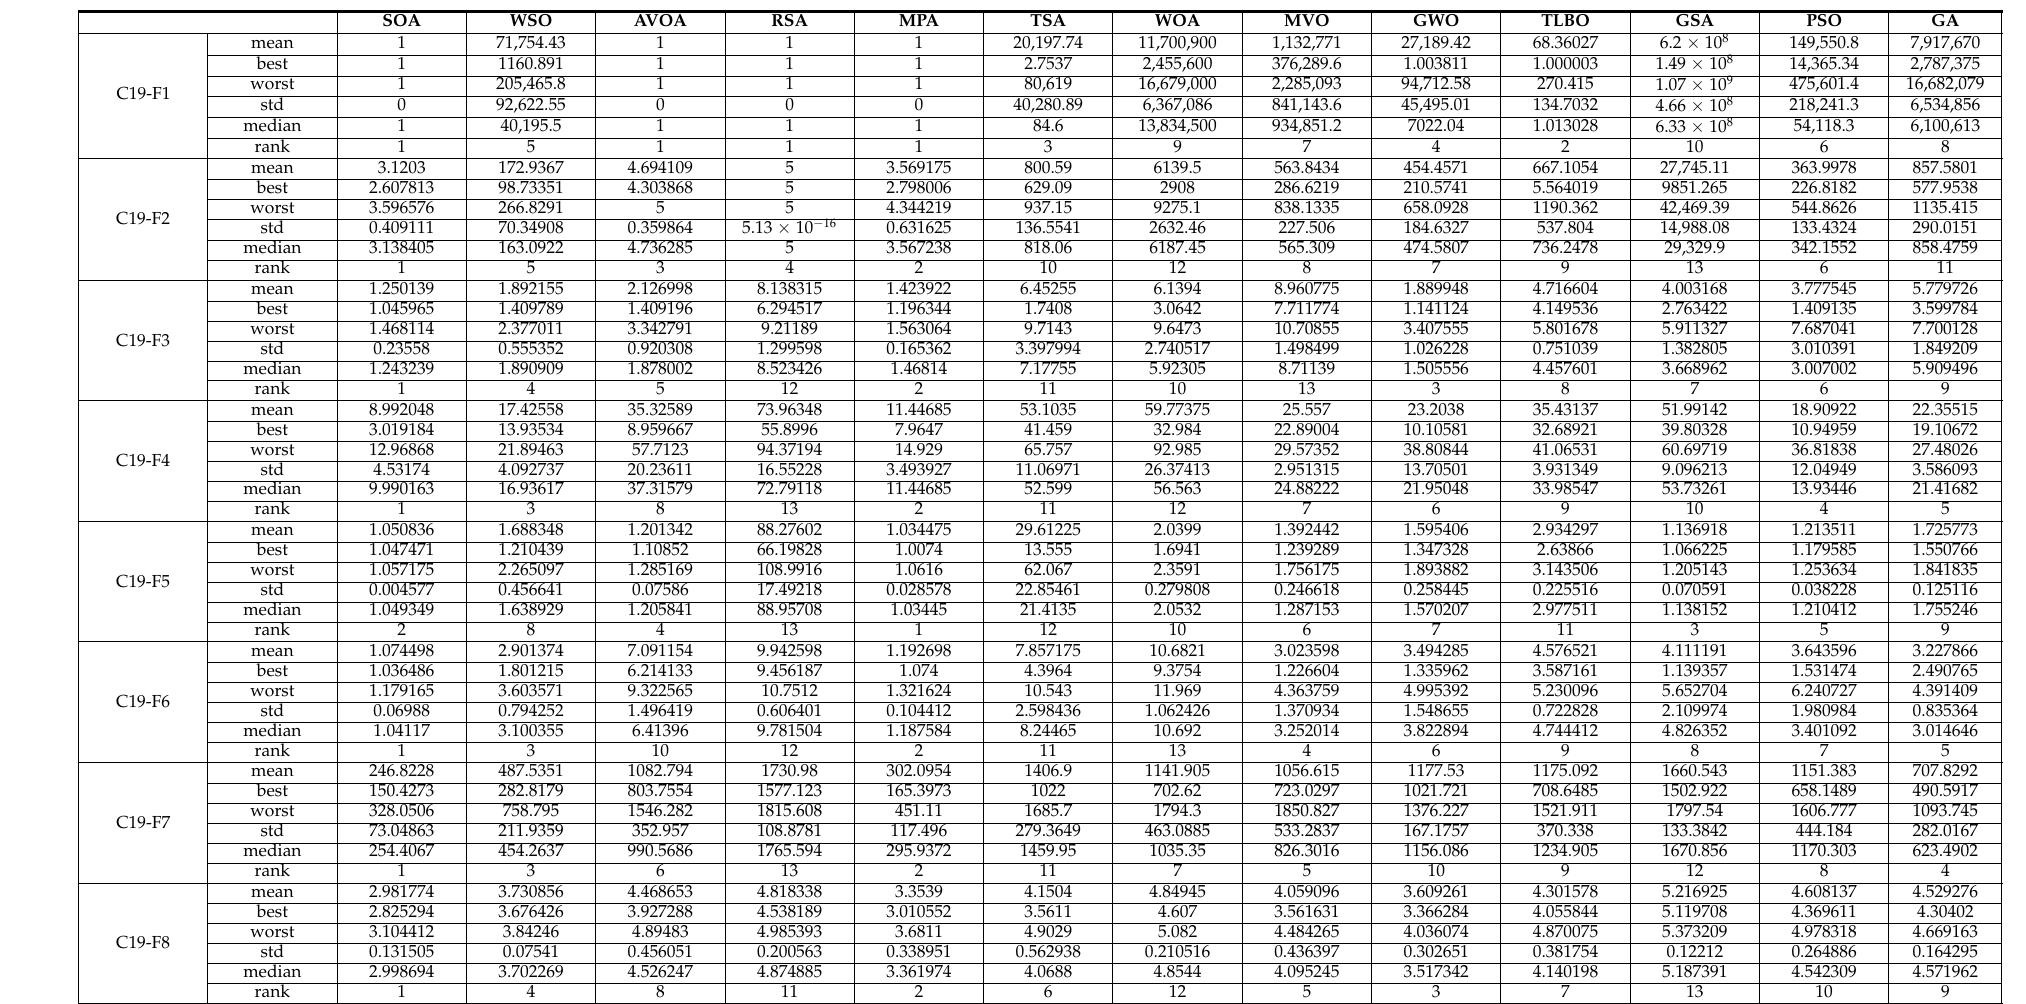
Table 6. Optimization results of the CEC 2019 test